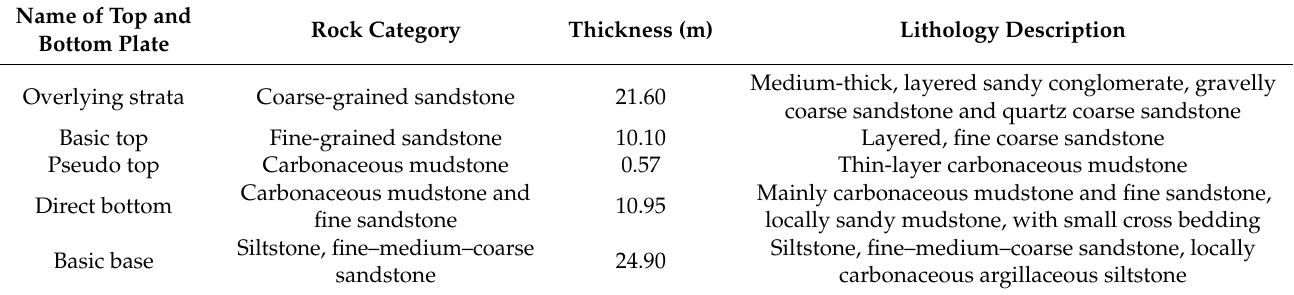
Table 1. Lithologic characteristics of roof and floor of VI 13 coal